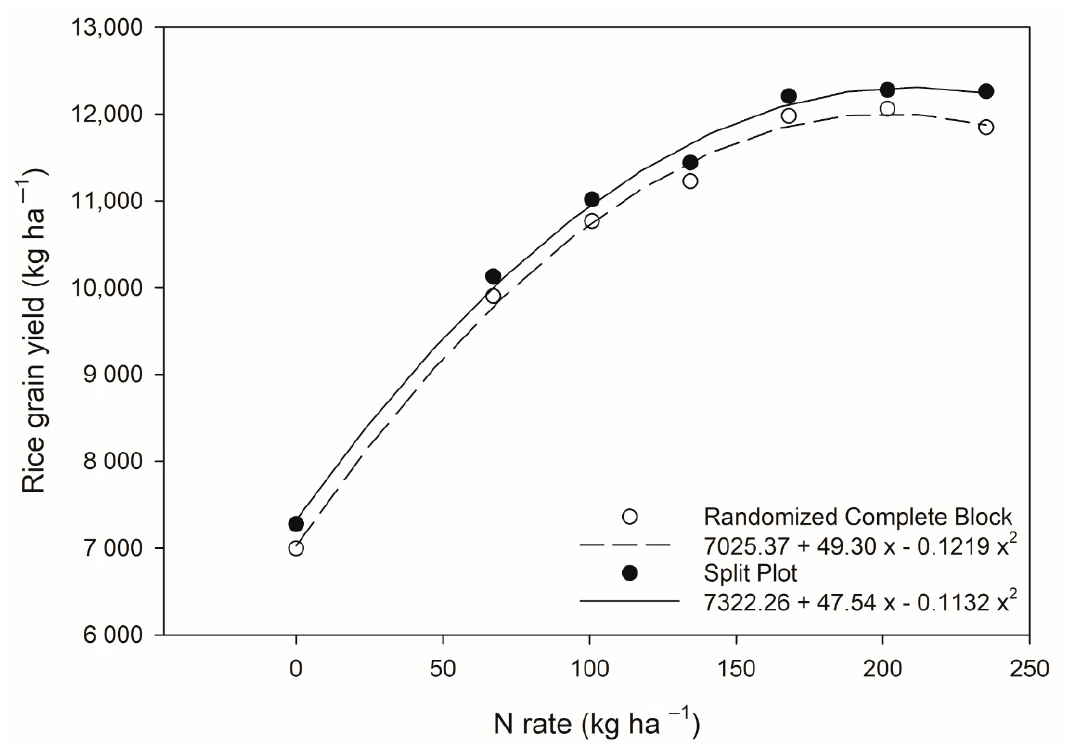
Agronomy 2021 , 11 , x FOR PEER REVIEW Figure 1. Rice grain yield response to N fertilizer rate for an experiment comparing the trend of a randomized complete block design to the trend of a split-plot experimental design for environments with a silt loam soil texture in 2013 and 2014.